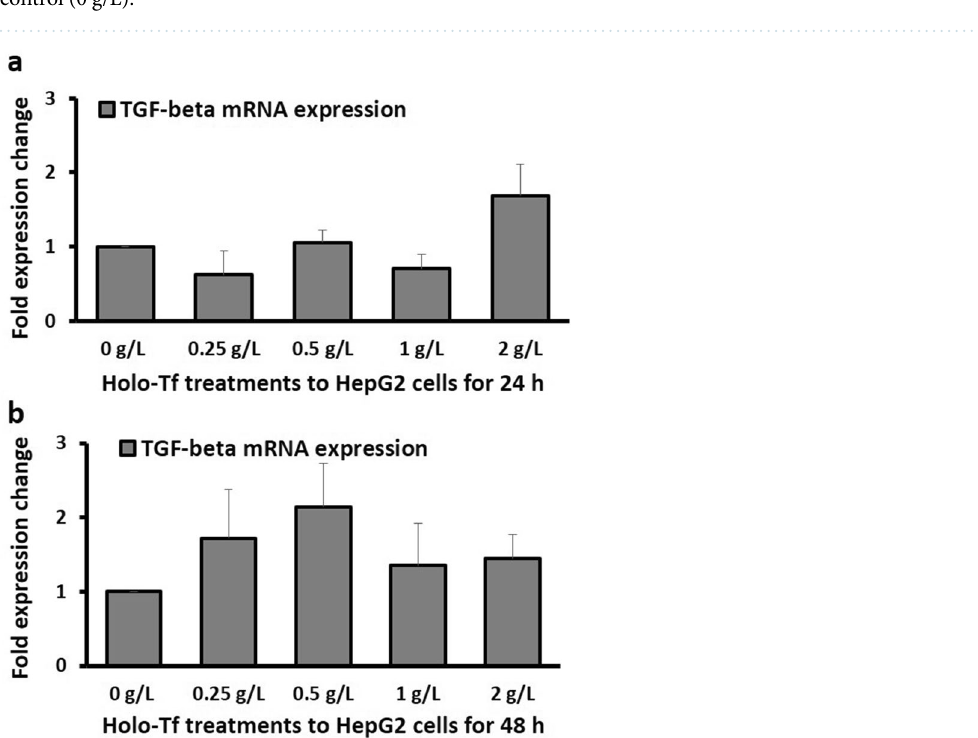
Figure 6. Effect of holo-transferrin on TGF-β expression. The effects of holo-Tf treatments on the mRNA expression of TGF-β for 24 h ( a ) and 48 h ( b ) have been shown. Data is presented as mean ± SEM (n =